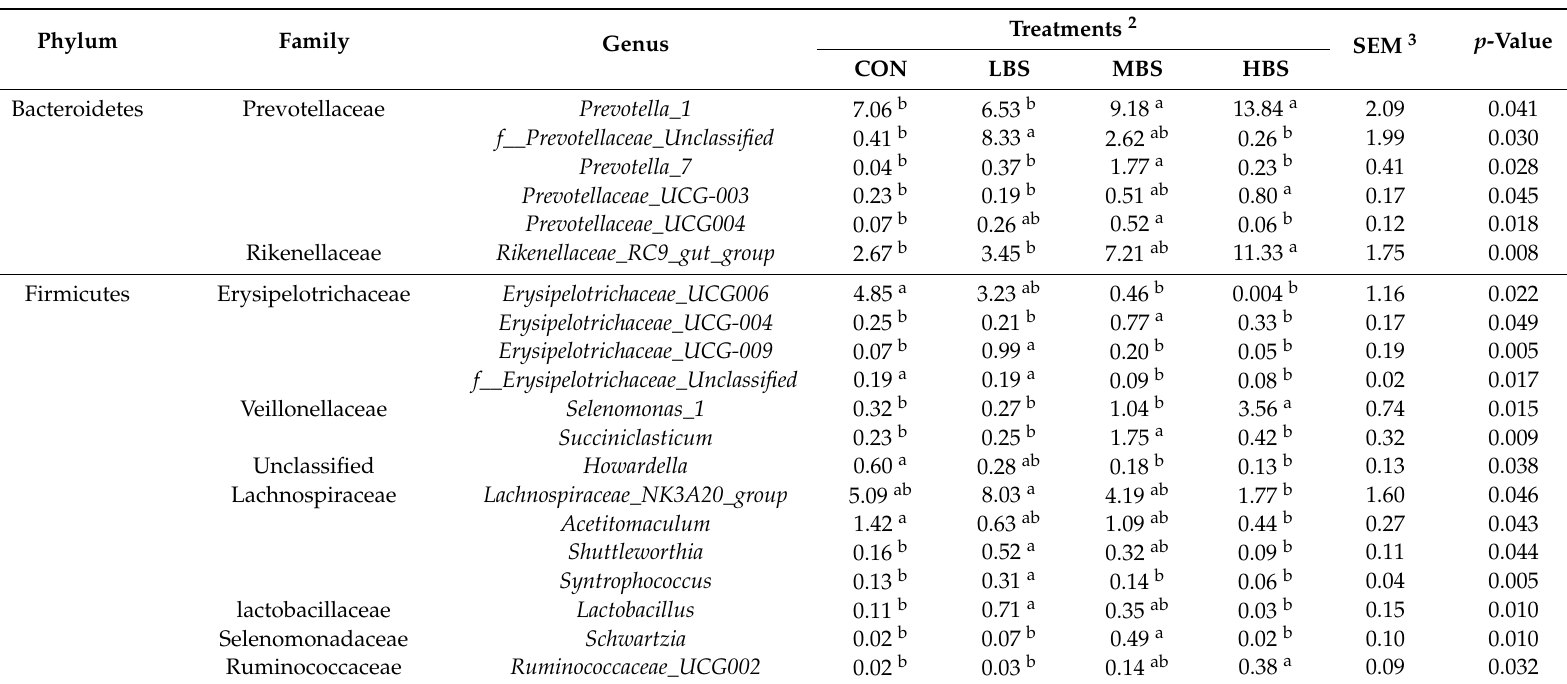
Table 6. E ff ects of β -sitosterol (BBS) supplementation on relative abundances of bacterial genera in rumen fluid using 16S rRNA sequencing 1 (%).